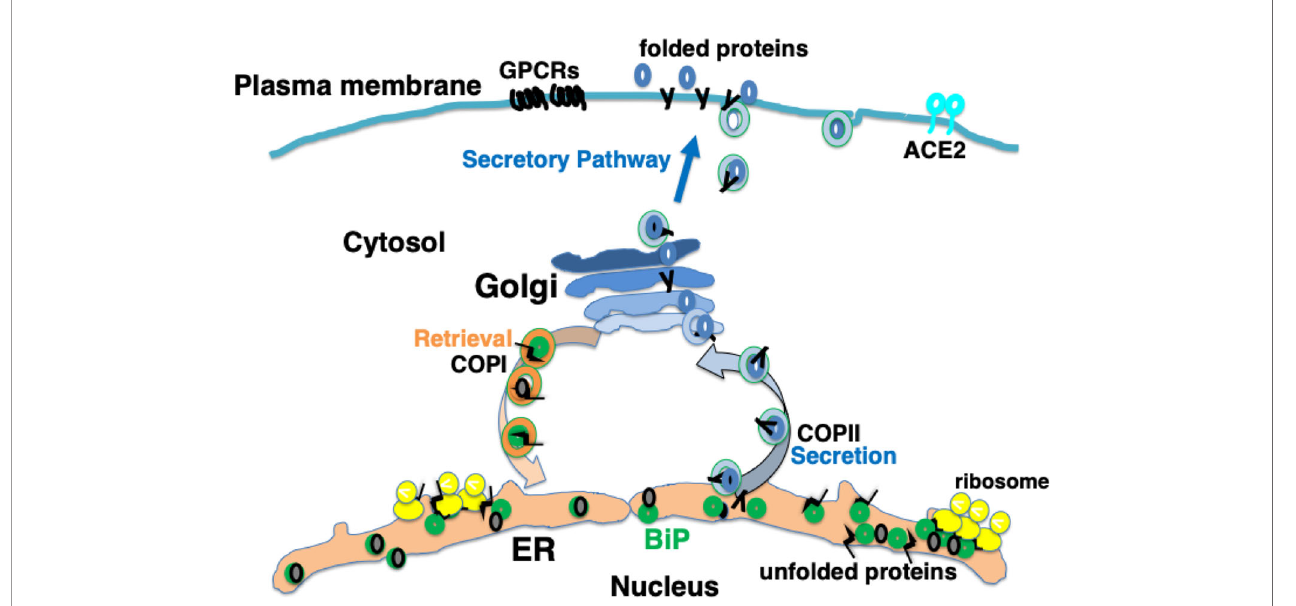
FIGURE 1 | Newly synthesized polypeptides are inserted into the endoplasmic reticulum (ER). Properly folded proteins are transported to the secretory pathway. Interaction with ER chaperones such as BiP facilitates proper folding of nascent proteins. Mature proteins are released into the secretory pathway via coat protein II (COPII) vesicular transport. A certain fraction of KDEL proteins, such as BiP, associating with unfolded proteins are secreted; these are retrieved via KDEL receptors from the cis-Golgi to the ER through COPI vesicular